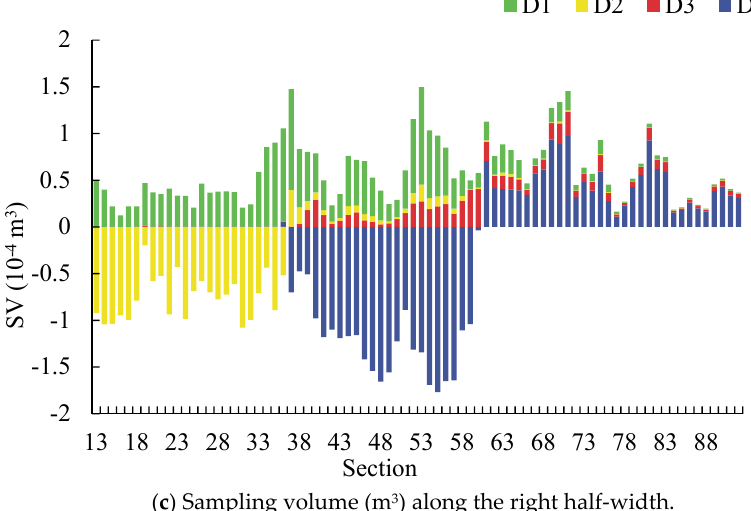
Figure 2. ( a ) Bed elevation change (Run 110/1, unit: cm, flow from left to right). ( b ) Sample volume (unit: m 3 ) of grains D 1 , D 2 , D 3 , D 4 at each section along the left bank. ( c ) Sampling volume (unit: m 3 ) of grains D 1 , D 2 , D 3 , D 4 at each section along the right bank. D 1 , D 2 , D 3 , D 4 grains are represented by green, yellow, red, and cyan colors, respectively.